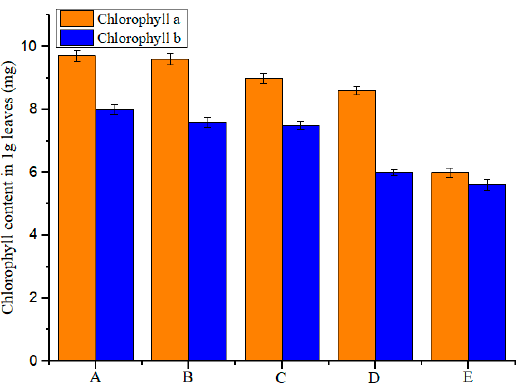
Figure 12. Chlorophyll content results: ( A ) water; ( B ) β -CD; ( C ) diuron; ( D ) physical mixture; and ( E ) the inclusion complex.